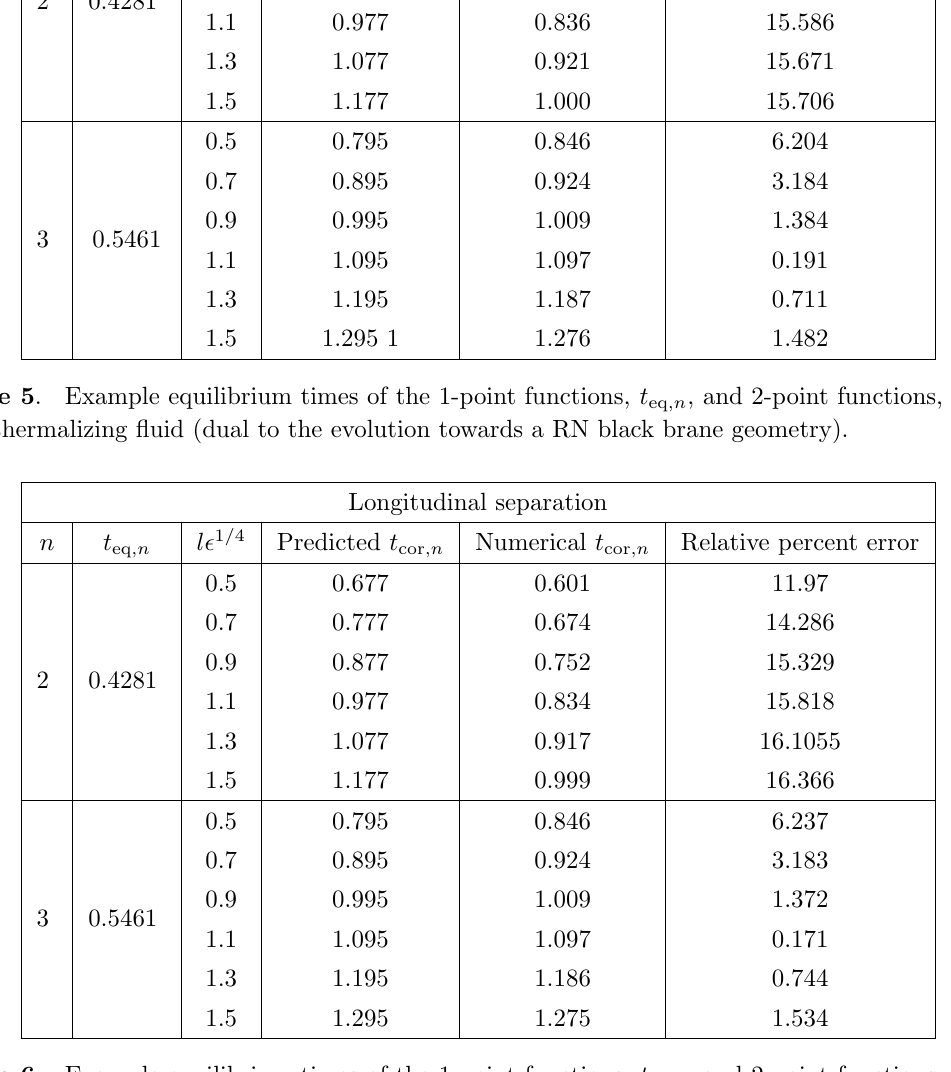
Table 6 . Example equilibrium times of the 1-point functions, t eq ;n , and 2-point functions, t cor ;n , in a thermalizing (cid:13)uid (dual to the evolution towards a RN black brane